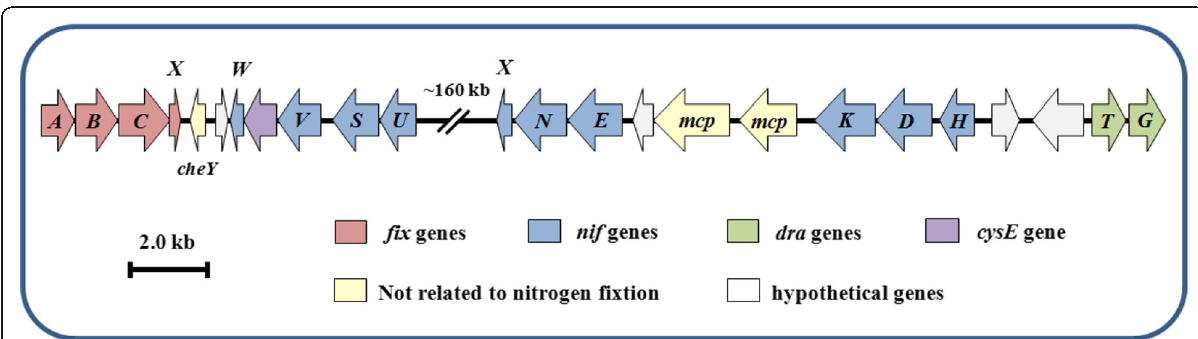
Fig. 4 Organization of the nitrogen fixation gene cluster in A. humicireducens SgZ-5 T . Arrows represent genes and their respective direction of transcription. Genes are colored as depicted in the lower